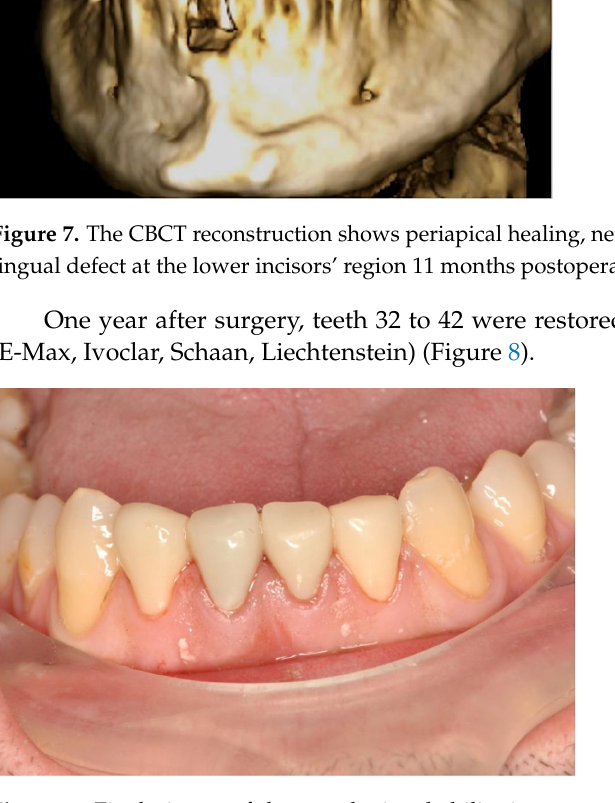
Figure 8. Final picture of the prosthetic rehabilitation one year after the operation with lithium dis- ilicate crowns (E-Max, Ivoclar, Schaan, Liechtenstein) of the teeth 32 to 42. disilicate crowns (E-Max, Ivoclar, Schaan, Liechtenstein) of the teeth 32 to